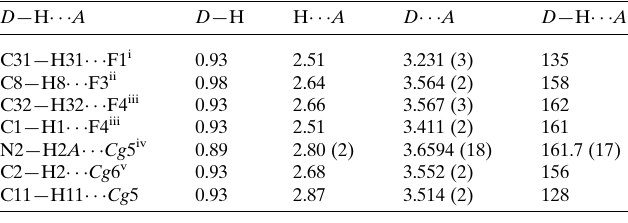
Table 1 Hydrogen-bond geometry (A˚ , (cid:3) ).